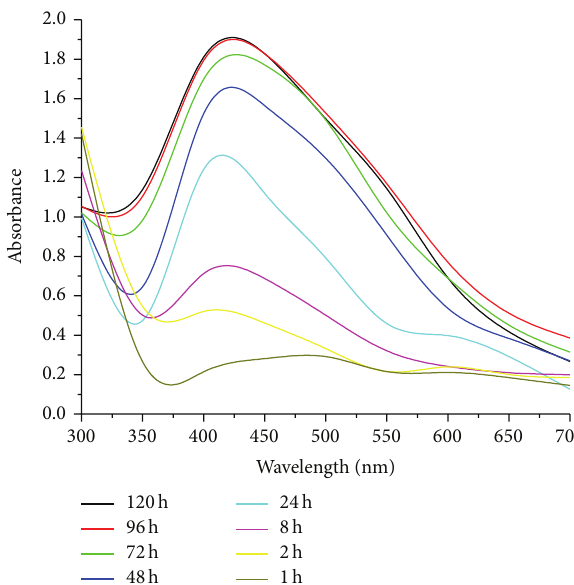
Figure 7: UV-visible absorption spectra of biosynthesized AgNps at different time intervals.